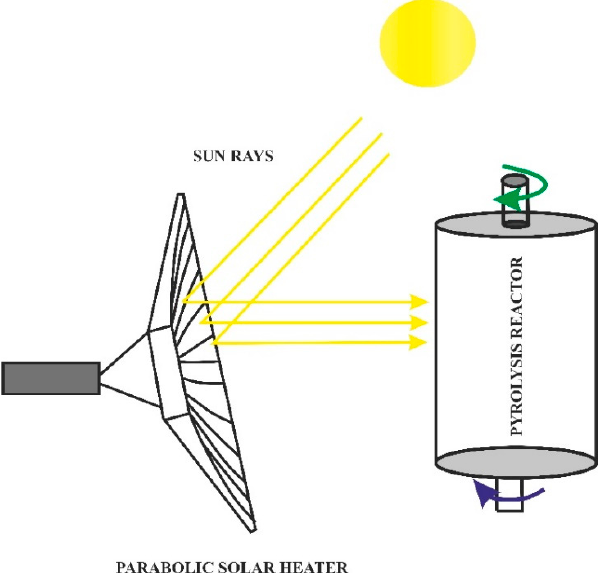
Figure 6. Principle of solar pyrolysis.